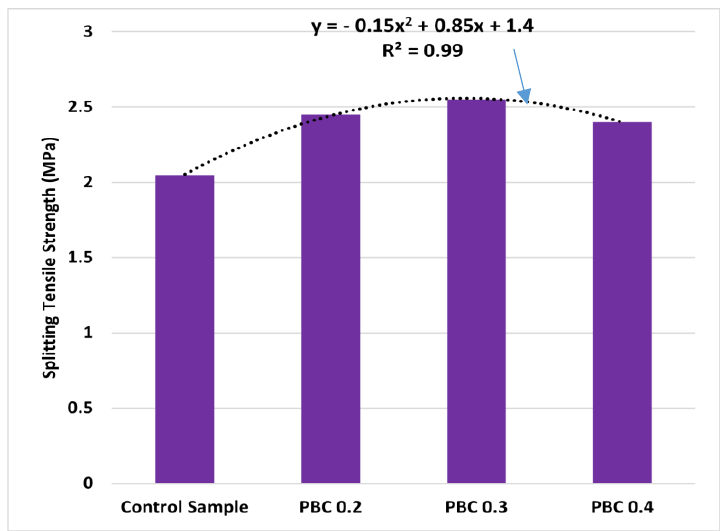
Figure 10. Split Tensile strength of CCF IPB at 28 days.